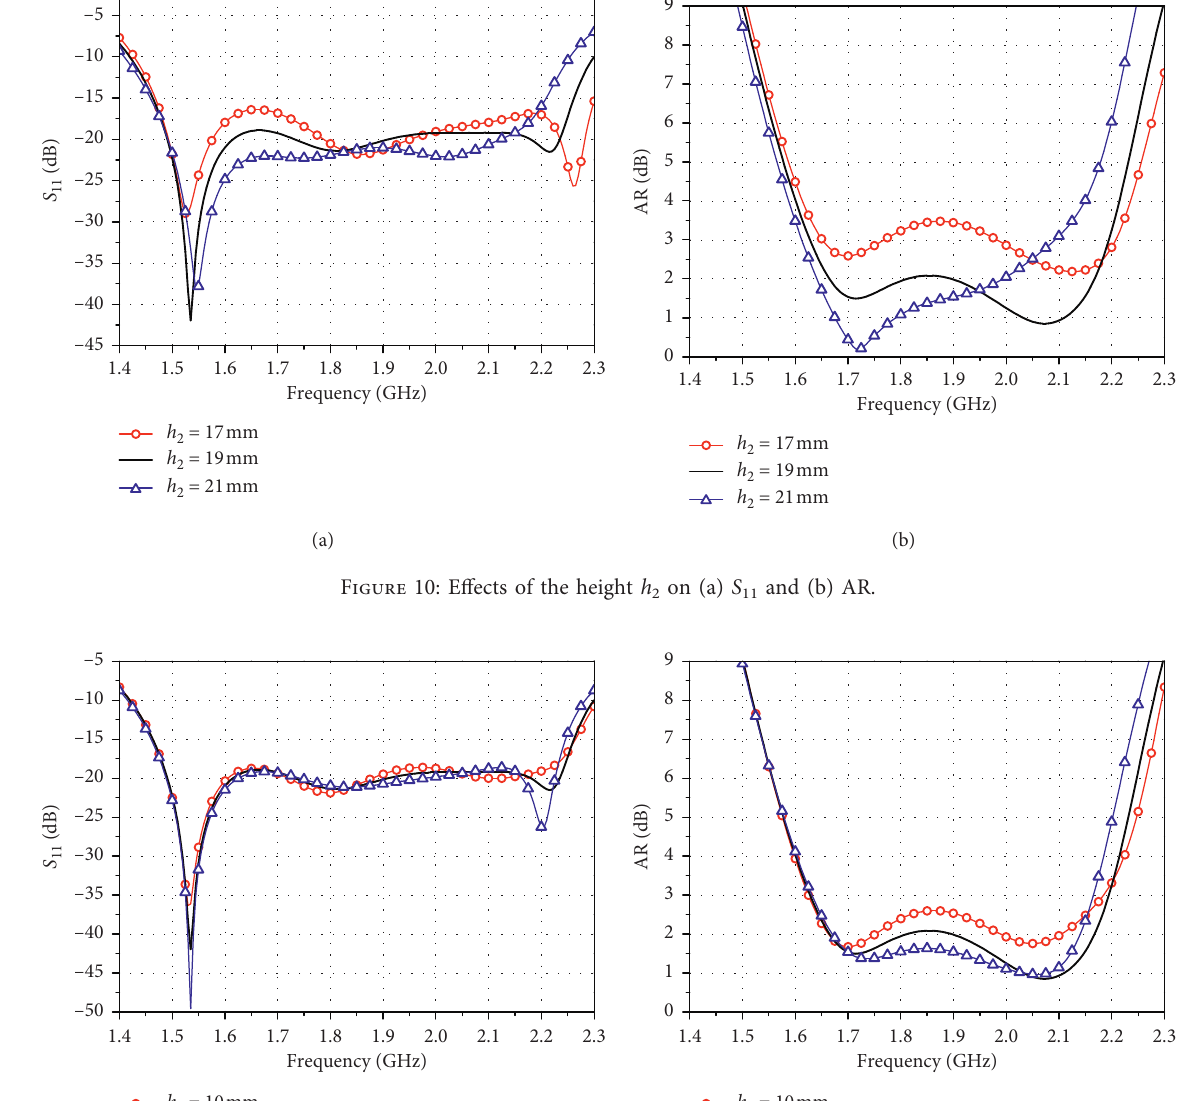
3 on (a) S 11 and (b)